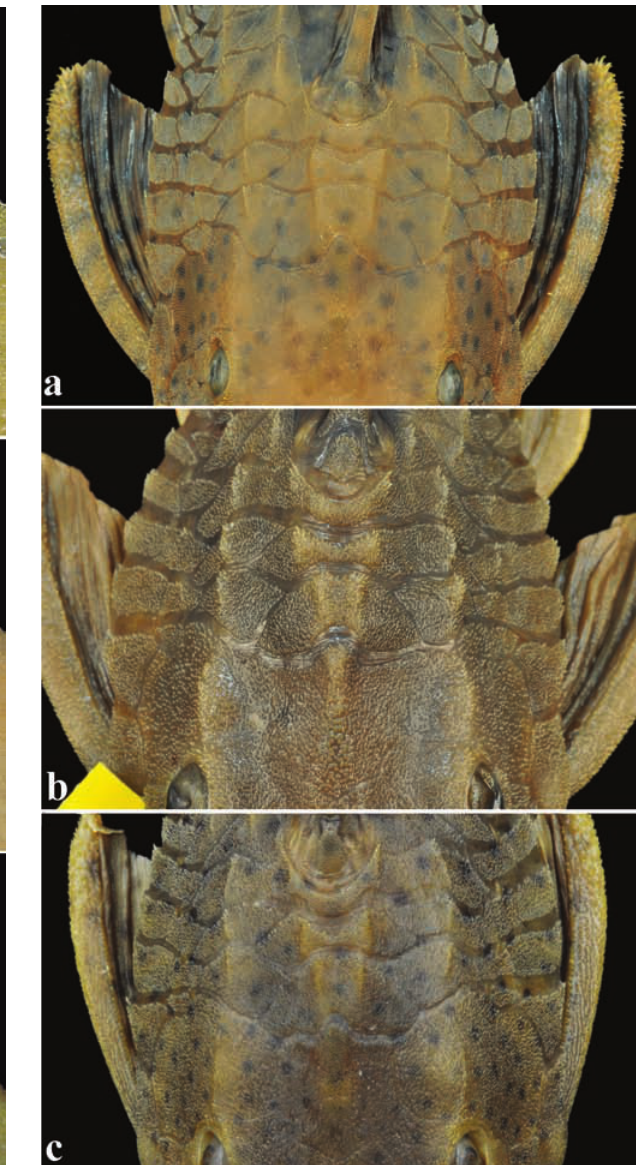
Fig. 6. Keels, ridges and odontodes of (a) Hypostomus cochliodon , NUP 10807, 208.0 mm SL, showing two weakly developed ridges in compound pterotic, weakly developed keels, few and weakly developed odontodes and predorsal keels weakly developed; (b) Hypostomus basilisko , holotype, MZUSP 111110, 182.5 mm SL, showing the three ridges on top of head, strongly developed keels, numerous well- developed odontodes on plates covering body and head and strong V-shaped predorsal keels; (c) Hypostomus khimaera , holotype, MZUSP 111129, 139.1 mm SL, showing moderately developed keels and dermal plates supporting moderately developed